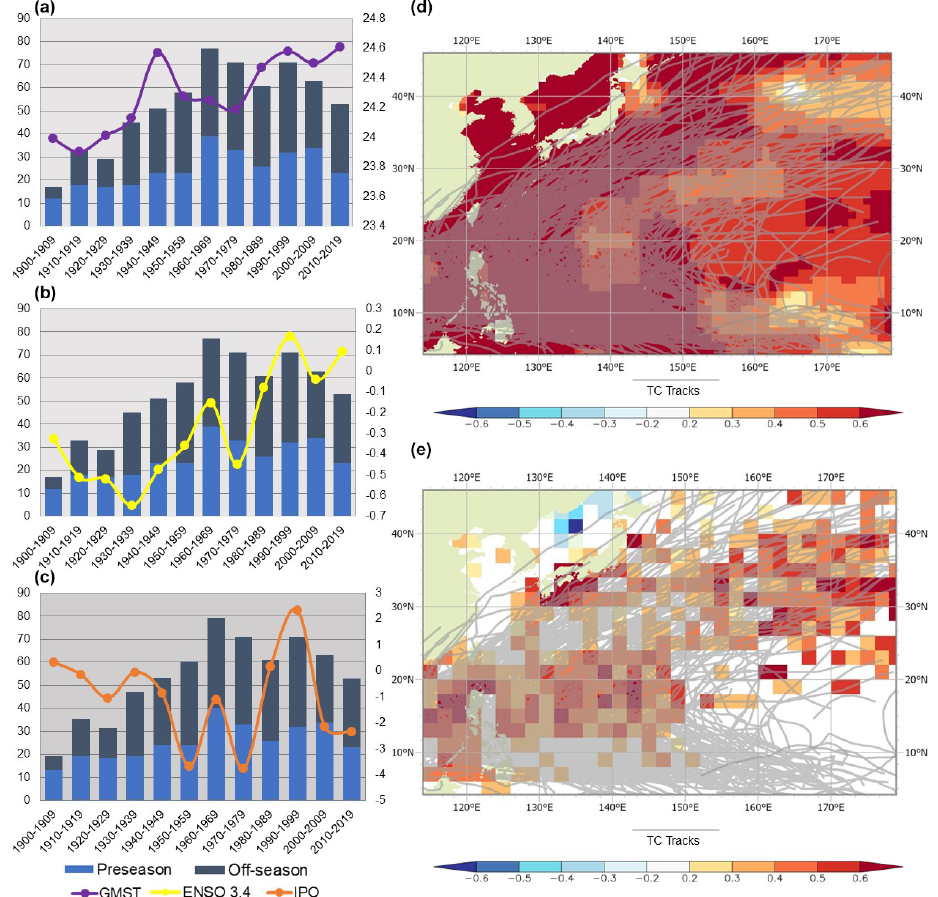
Figure 5. Decadal TC counts for the WP off-seasons and decadal average SSTs (a) ; decadal TC counts for the WP off-seasons and decadal average AMO (b) ; decadal TC counts for the WP off-seasons and decadal average correlation between time and December–May-averaged CC (c) ; correlation between time and December–May-averaged SST ( ◦ C) and the off-season TC tracks for the 1900–2019 period (d) ; and correlation between time and December–May-averaged CC (oktas) and the off-season TC tracks for the 1900–2019 period (e)